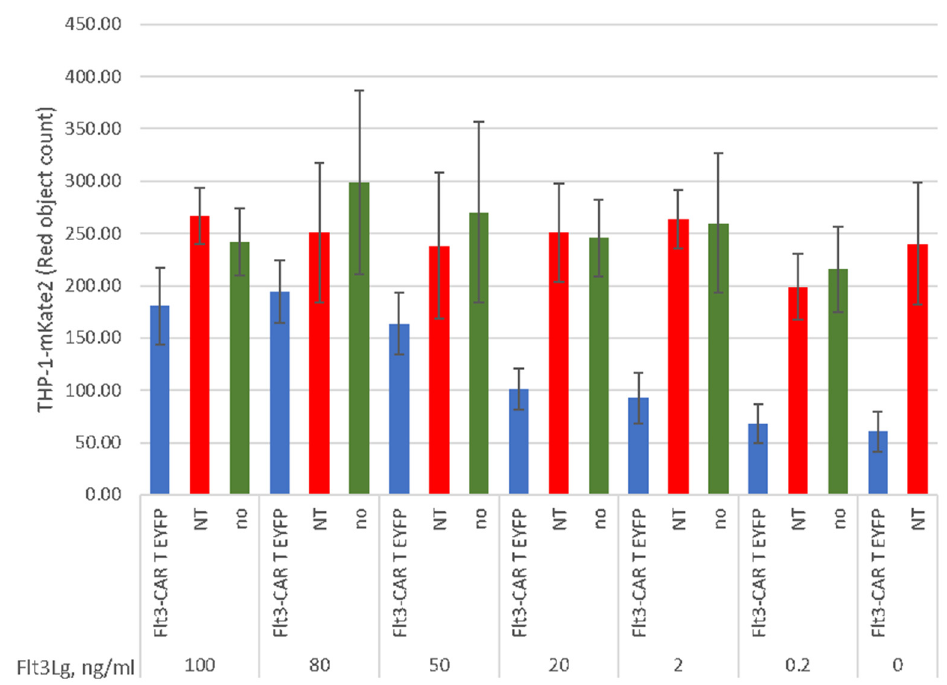
Figure 7. Dose-dependent inhibition of Flt3-CAR T cell-mediated killing with soluble Flt3Lg. The ligand was added at indicated concentrations to the co-incubation medium prior to the experiment. THP-1-mKate2 cells were co-incubated with Flt3-CAR T cells (blue bars), non-transduced T cells (red bars), or no T cells (green bars). ‘Red object counts’ acquired by IncuCyte ® over 45 h co-incubation reflect the viability of THP-1-mKate2 cells. The data are represented as means ± SD.